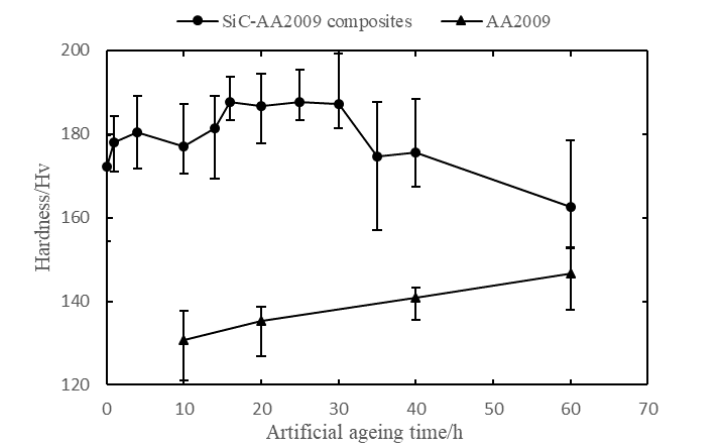
Figure 3. Comparison of hardness variations along the ageing time under CHT strategy of SiCp– AA2009 composites and AA2009.